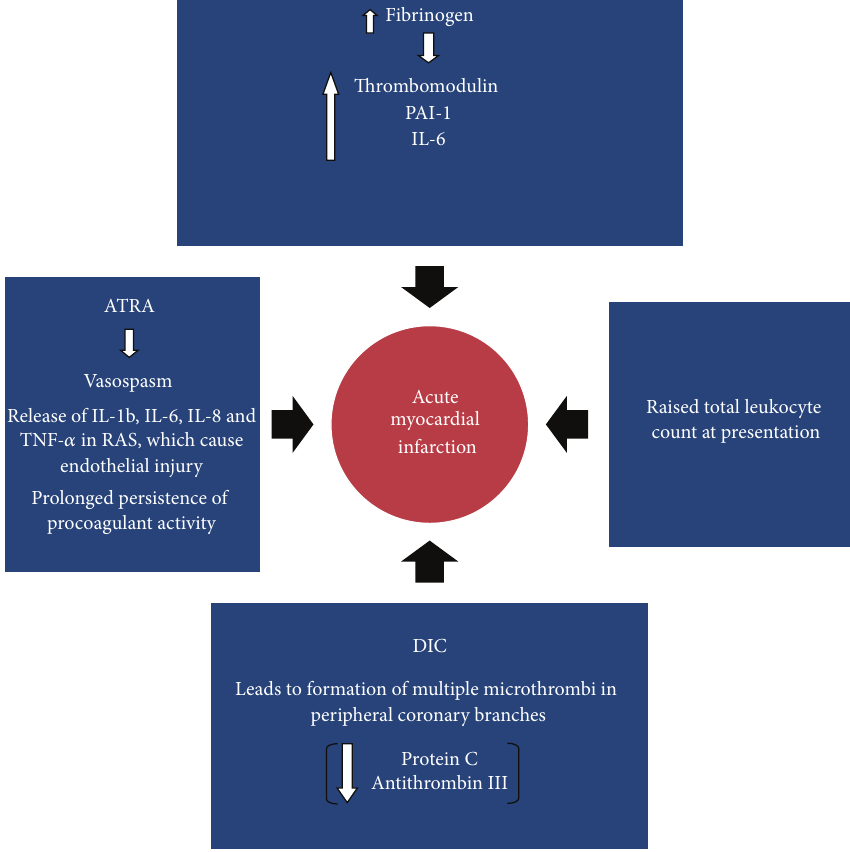
Figure 8: The possible mechanisms of acute coronary syndrome in the setting of